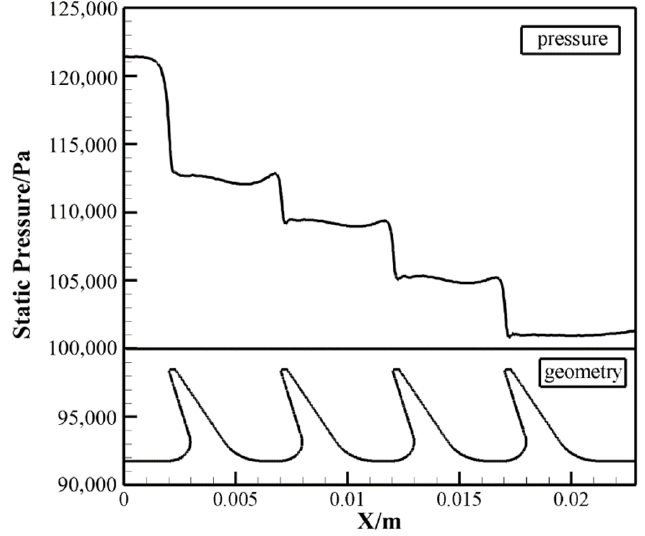
Figure 16. Pressure drop of fluid along the flow path.